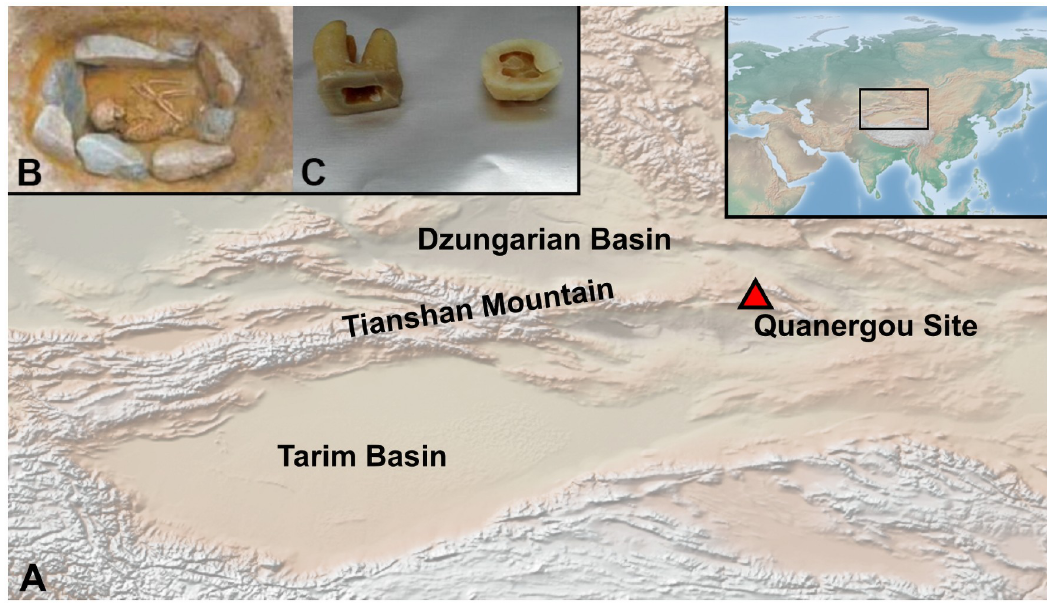
Fig 1. Geographical origin and depiction of archaeological samples. A. Geographical location of the XBQ site in this study. Map made with Natural Earth (https://www.naturalearthdata.com/downloads/50m-raster-data/50m-cross-blend-hypso/). B. A child buried in a stone coffin. C. The tooth was sectioned at the cementoenamel junction and a sample was drilled from the crown pulp chamber.